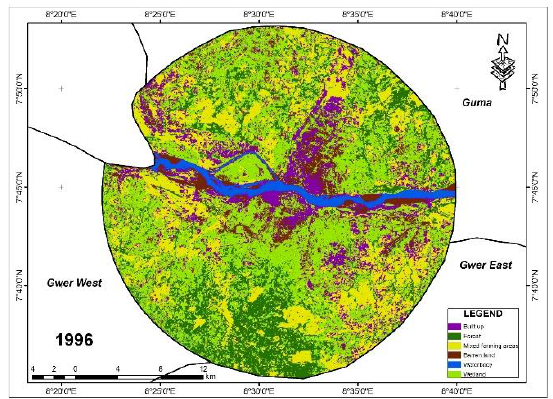
Figure 3. Landuse composition of study area in 1996.